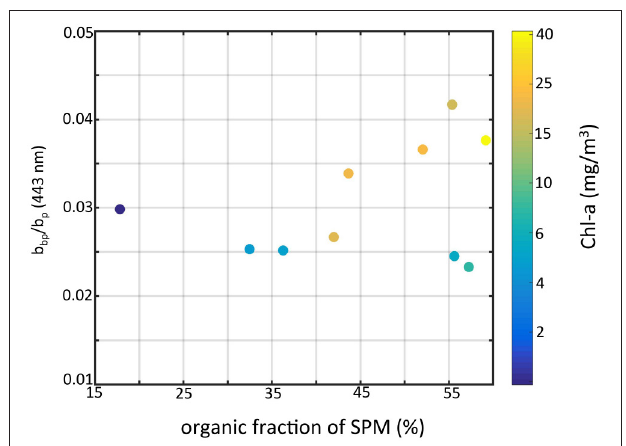
FIGURE 8 | Particle backscattering ratio at 443 nm vs. the fraction of organic particles of SPM color-coded by chlorophyll-a